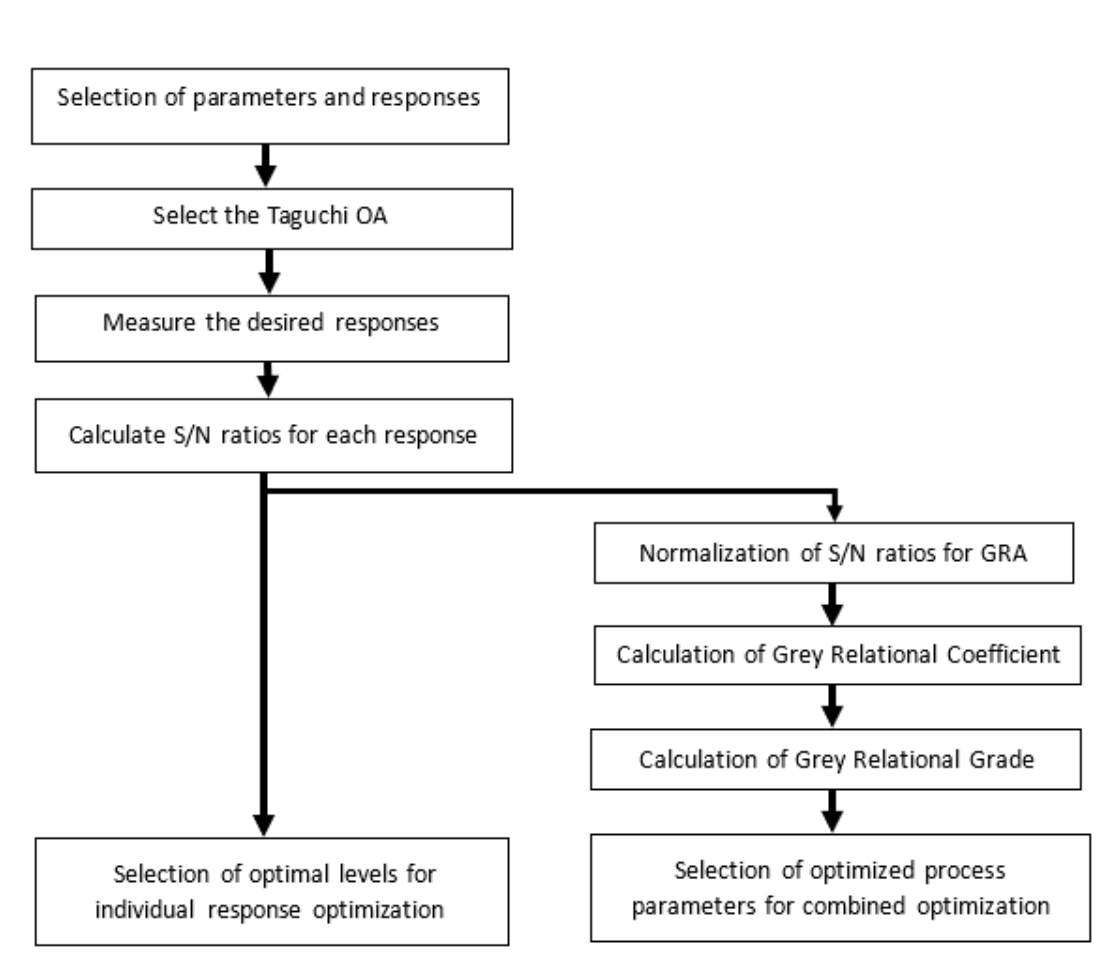
Figure 5. Concept behind PCA-GRA.